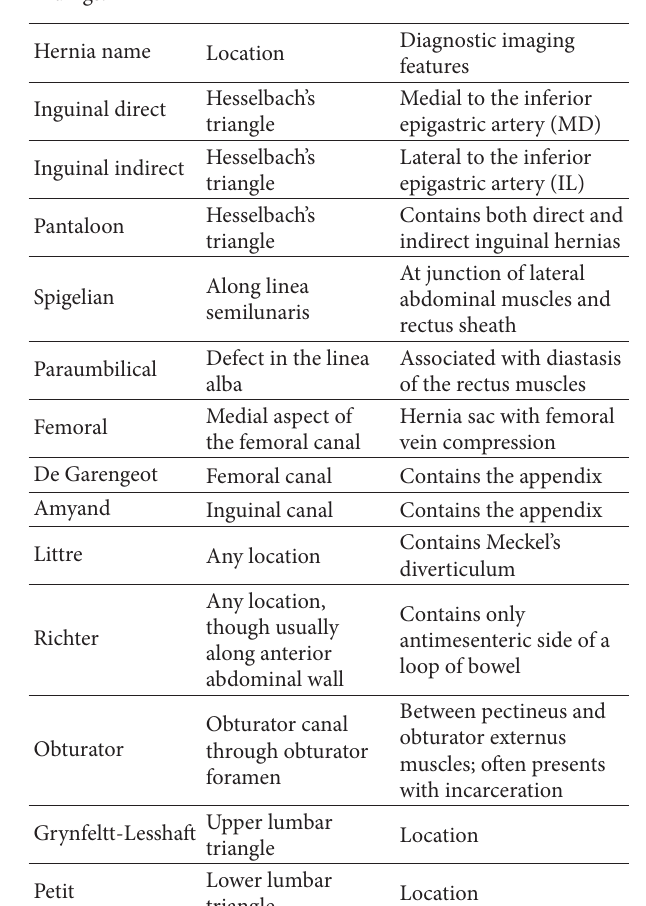
Table 1: Hernia types with typical location and diagnostic